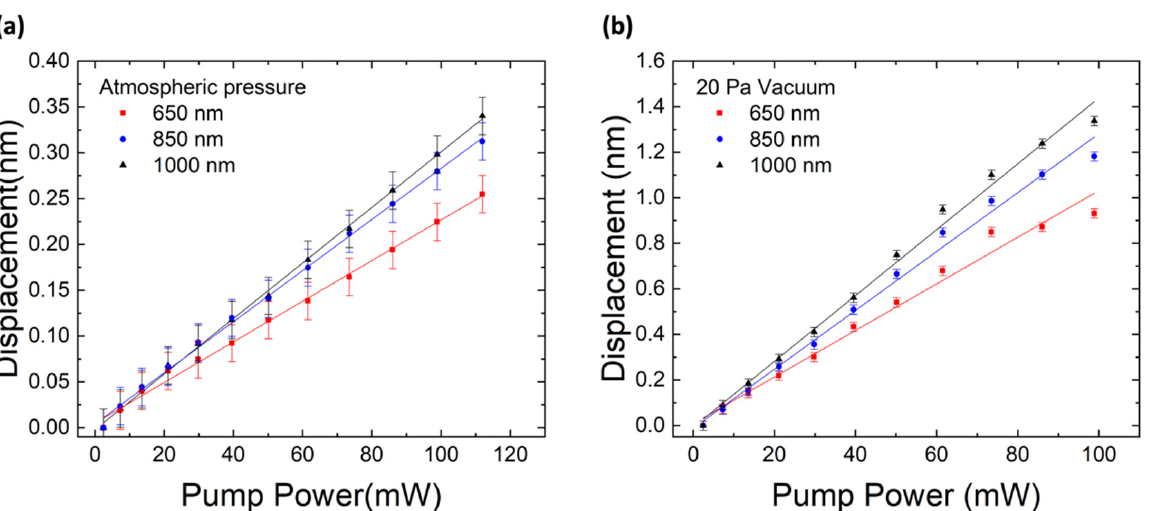
Figure 3. Displacement of the WGM peaks as a function of laser pump power ( a ) at atmospheric pressure and ( b ) at 20 Pa vacuum. Error bars represent standard error of 20.4 pm. Table 1. Displacement rates obtained as a function of laser pump power.